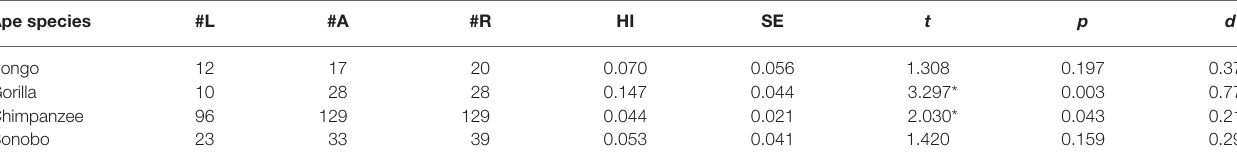
TABLE 1 | Distribution of handedness and mean HI scores for unimanual reaching in each species.